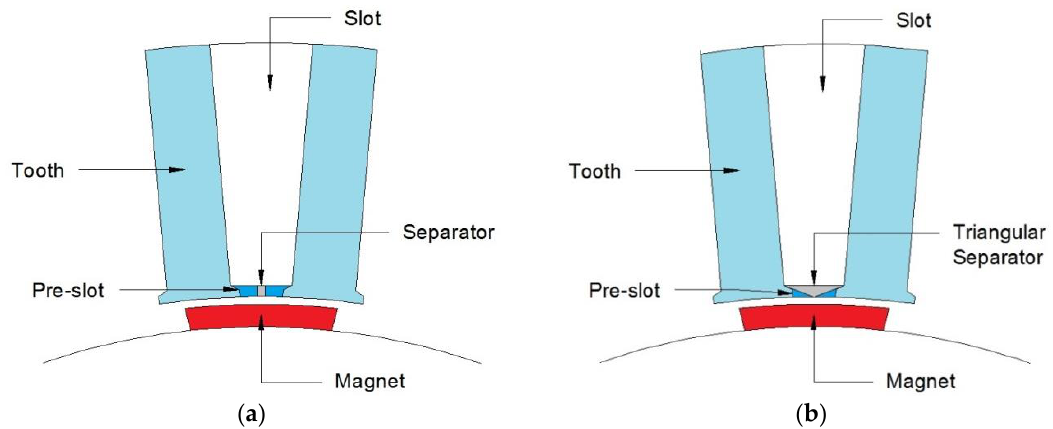
Figure 6. Proposed cogging-torque reduction method: ( a ) Pre-slot with separator; ( b ) Pre-slot with triangular separator.